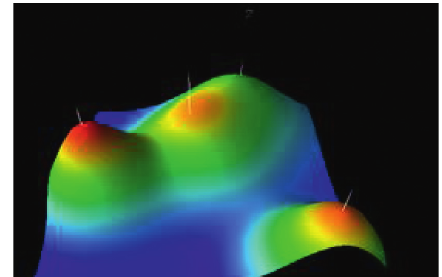
Figure 4: System cluster of keywords.